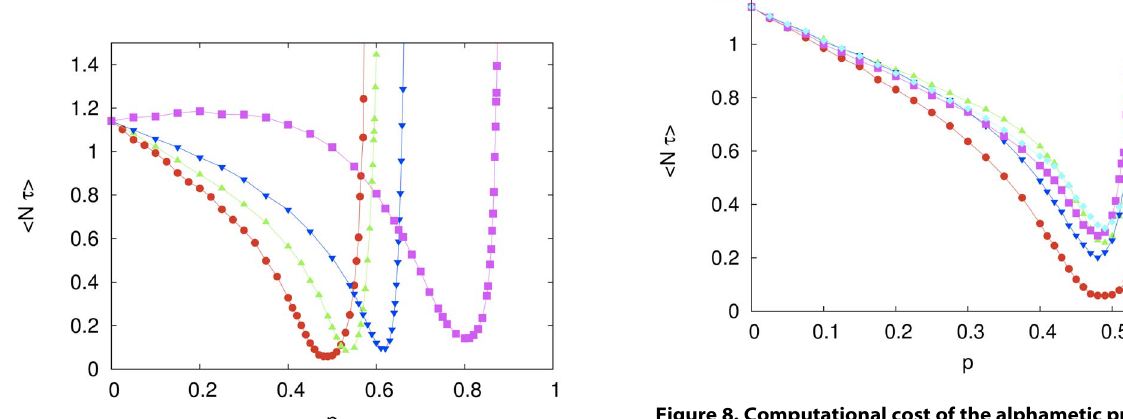
Figure 8. Computational cost of the alphametic problem and of four random cryptarithmetic problems. The mean rescaled computational cost for the alphametic problem DONALD z GERALD ~ ROBERT (red circles) and for four ten-letter random cryptarithmetic problems with a unique solution (blue inverted triangles, magenta squares, cyan diamonds and green triangles). The symbols represent the mean rescaled computational cost S N t T for a system composed of N ~ 20 fully connected agents. The independent variable p is the imitation probability. The influence network size is M ~ N { 1 . Each symbol represents an average over 10 5 searches and the lines are guides to the eye. The error bars are smaller than the size of the